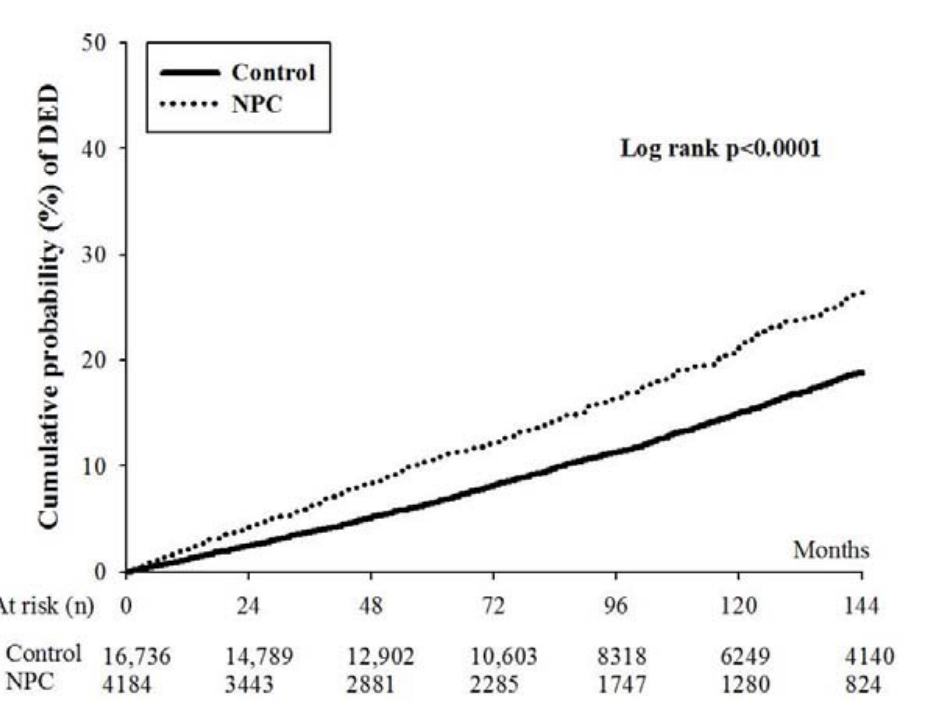
Figure 2. The Kaplan–Meier curves of the nasal pharyngeal carcinoma and non-nasal pharyngeal carcinoma populations.